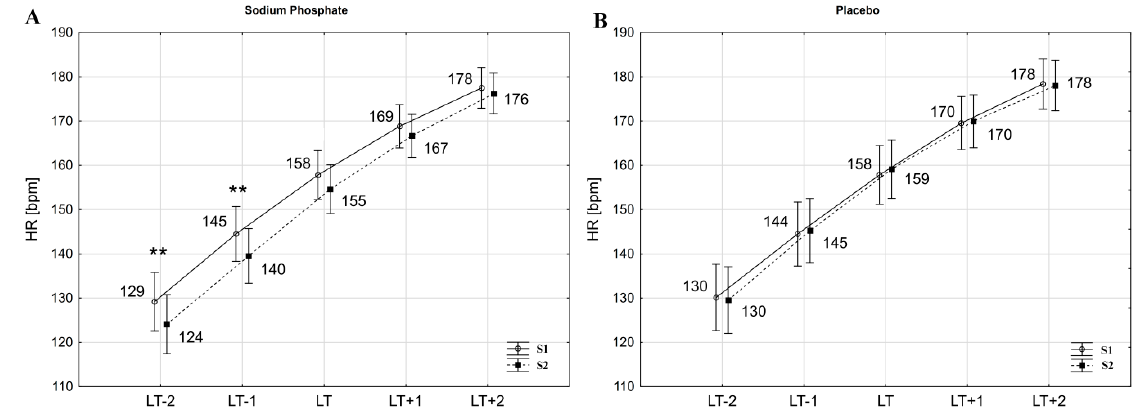
Figure 2. Heart rate (HR) during exercise in hypoxia before (S1) and after (S2) sodium phosphate ( A ) and placebo ( B ) ingestion. ** p < 0.01 S1 vs. S2. LT − 2, LT − 1, LT, LT+1, LT+2—absolute workload corresponding to workload at lactate threshold (LT) as well as one and two workloads below and above LT which were determined during the initial exercise test (S1).